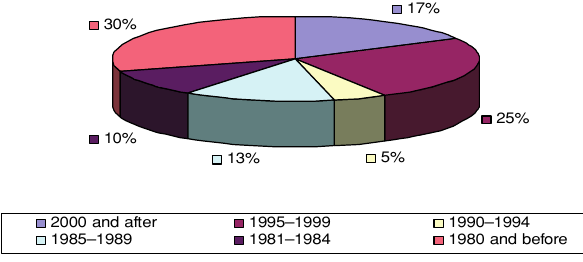
Source: Own figure based on CSO Figure 8: Times of establishment of sour cherry orchards in South Transdanubia